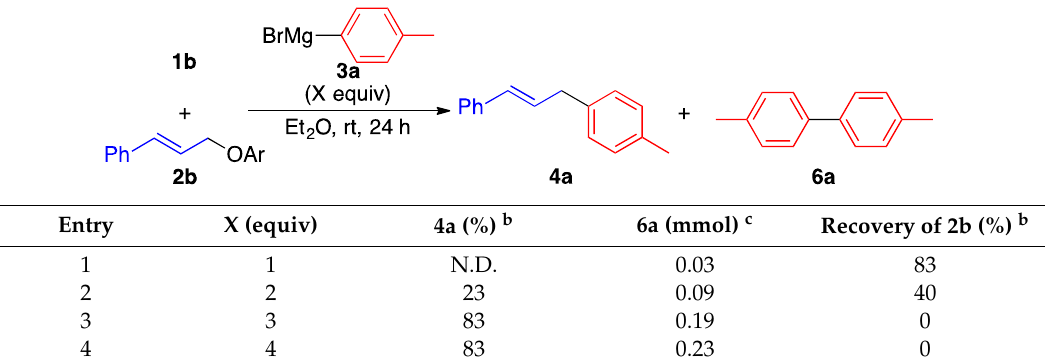
Table 6. The stoichiometric reaction of allylic ether 2b with aryl Grignard reagent 3a . a